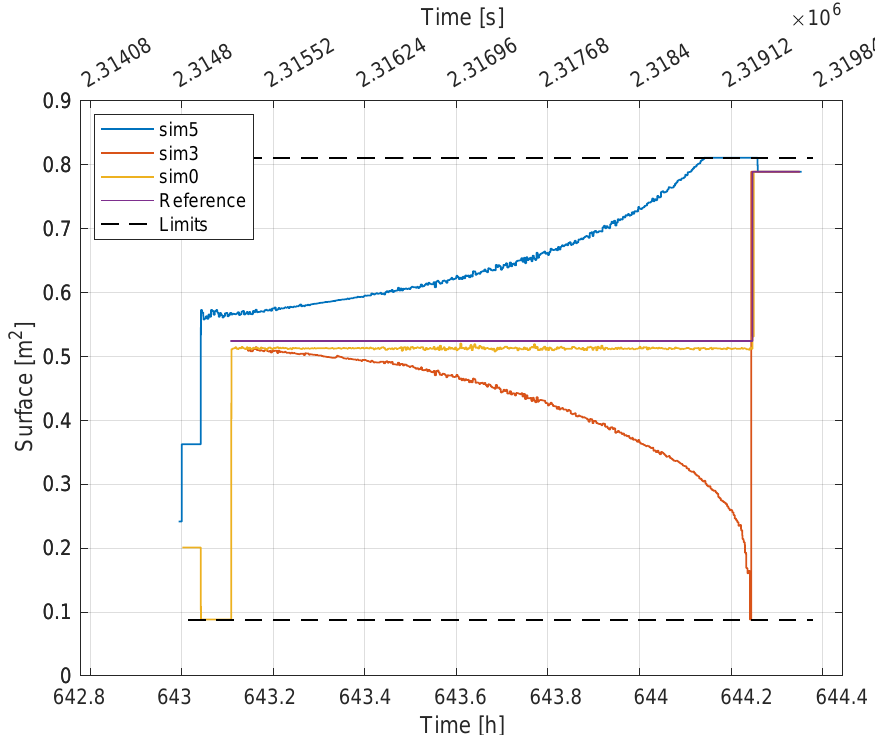
Figure 9. Optimized control law for the atmospheric approach phase. The bottom axis displays the time scale in hours, while the upper axis shows it in seconds.